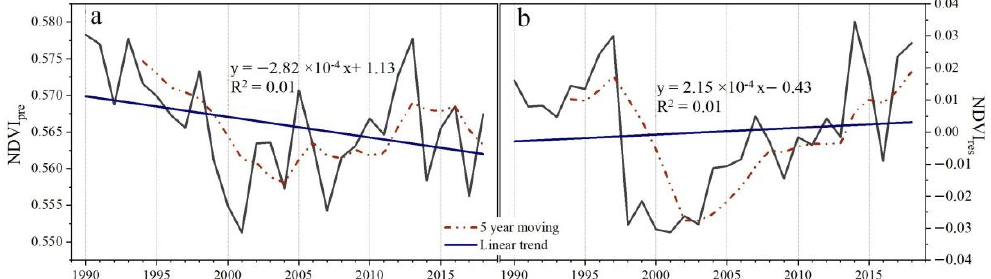
Figure 7. The temporal trends of NDVI impacted by climate factors ( NDVI pre , ( a )) and NDVI impacted by human activities ( NDVI res , ( b )) in Northeast China (NEC).